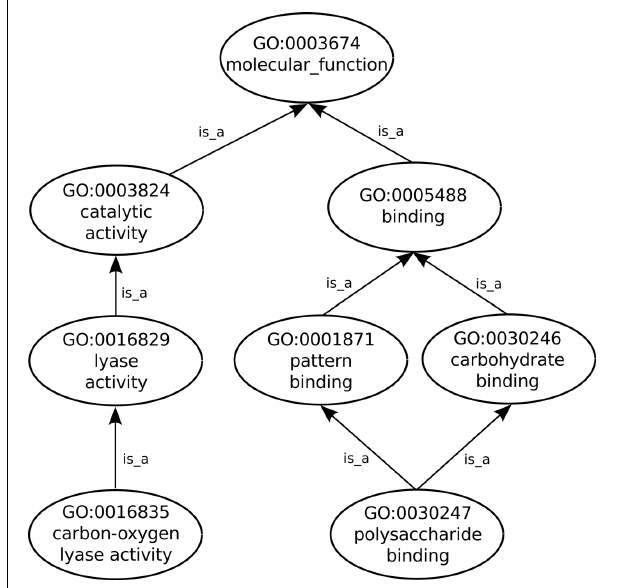
FIGURE 1 | Sub-graph of the GO molecular function ontology aspect depicting only is_a